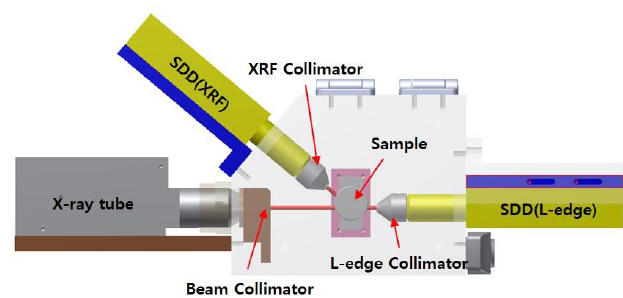
Fig. 1 Design of Hybrid L-edge/XRF Densitometer